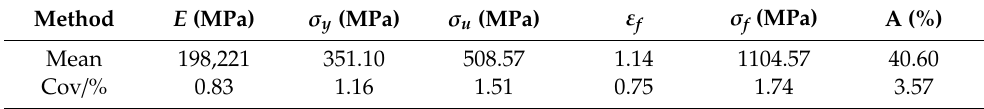
Table 1. Mechanical properties of Q345qC steel.